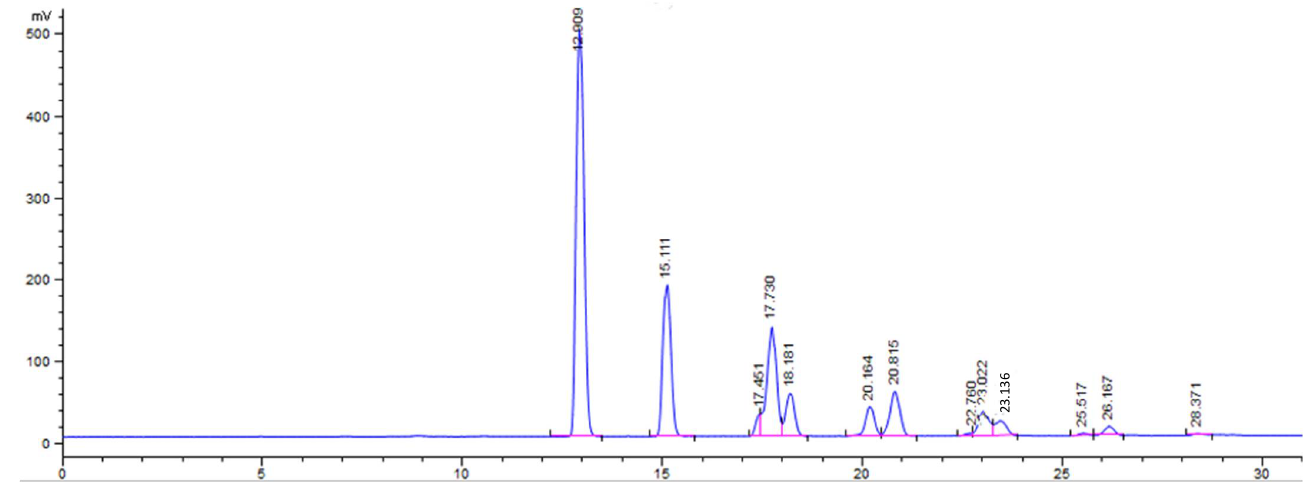
Figure 2. Chromatogram from triacylglycerol analysis.